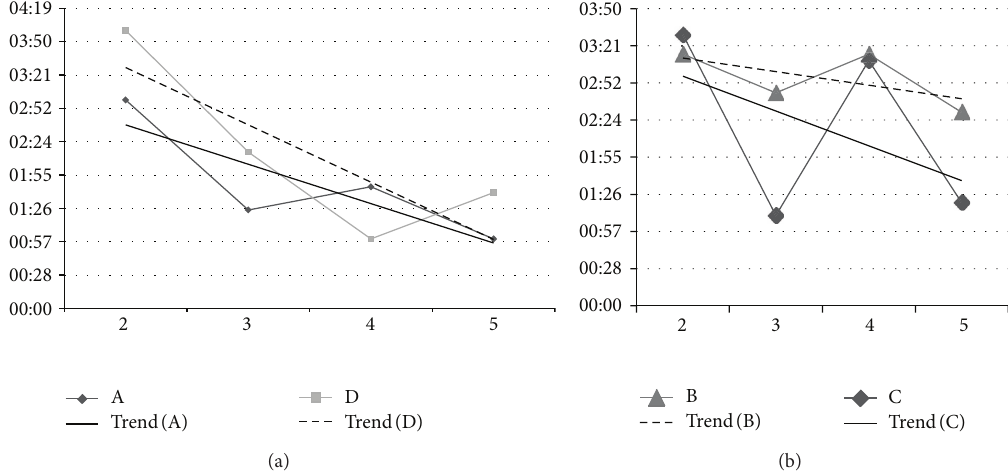
Figure 8: Execution time of experiments. Graphics show total time ([min:sec]) in experiments 2–4 and the downward trend of the times, denoting the training relevance. (a) Adults A and D are presented and (b) childs B and C are exposed.